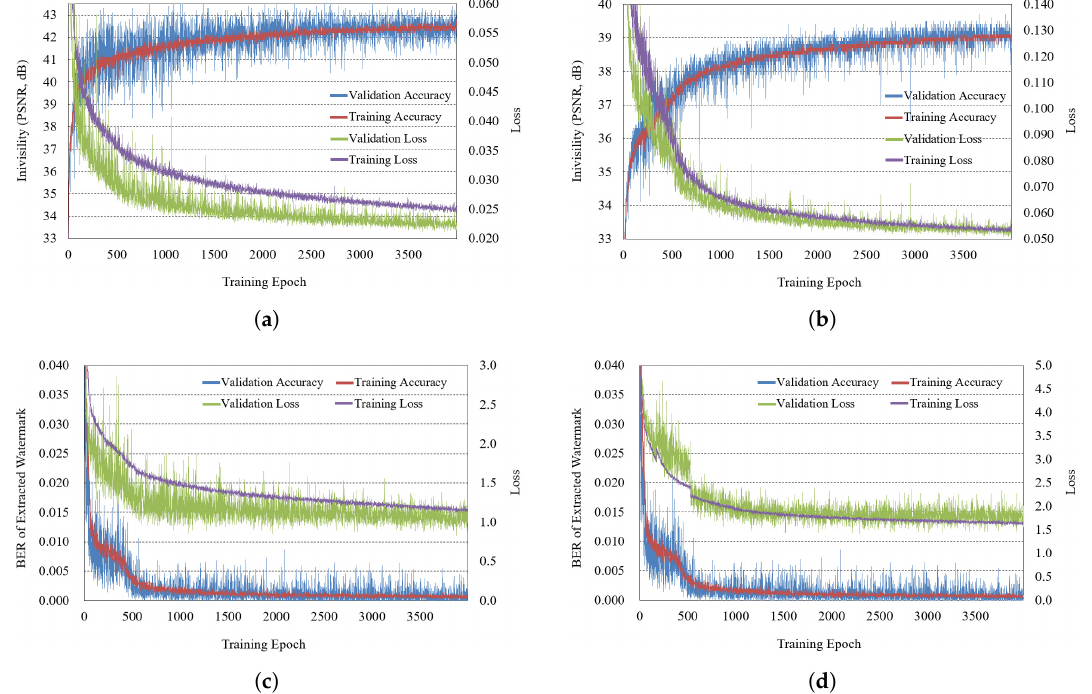
Figure 8. Training result with reconstruction ( a ) watermark embedding (real), ( b ) watermark embedding (amplitude), ( c ) extracting (real), ( d ) extracting